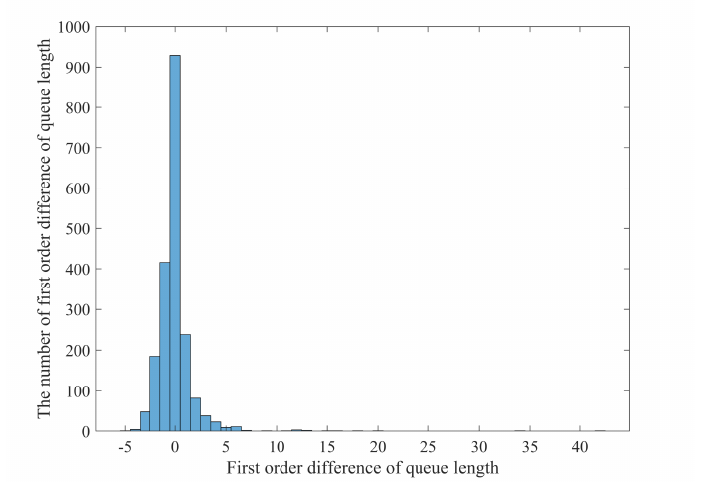
Figure 7. The first-order difference of queue length.